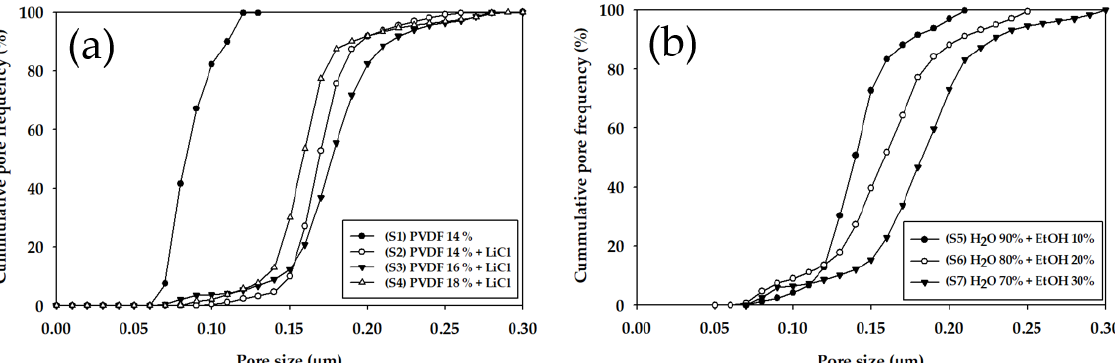
Figure 6. Cumulative pore frequency versus pore size of the membranes with different PVDF, LiCl concentration and non- solvent compositions: ( a ) (S1) PVDF 14 wt.% with water, (S2) PVDF 14 wt.% + LiCl with water, (S3) PVDF 16 wt.% + LiCl with water, and (S4) PVDF 18 wt.% + LiCl with water; ( b ) (S5) PVDF 16 wt.% + LiCl with water (90%) + EtOH (10%), (S6) PVDF 16 wt.% + LiCl with water (80%) + EtOH (20%), and (S7) PVDF 16 wt.% + LiCl with water (70%) + EtOH (30%).